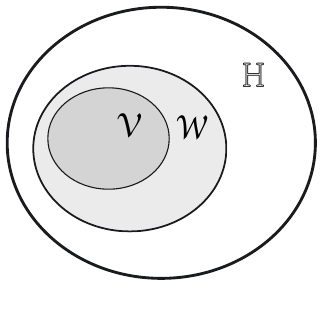
invariant sub-Hilbert 2